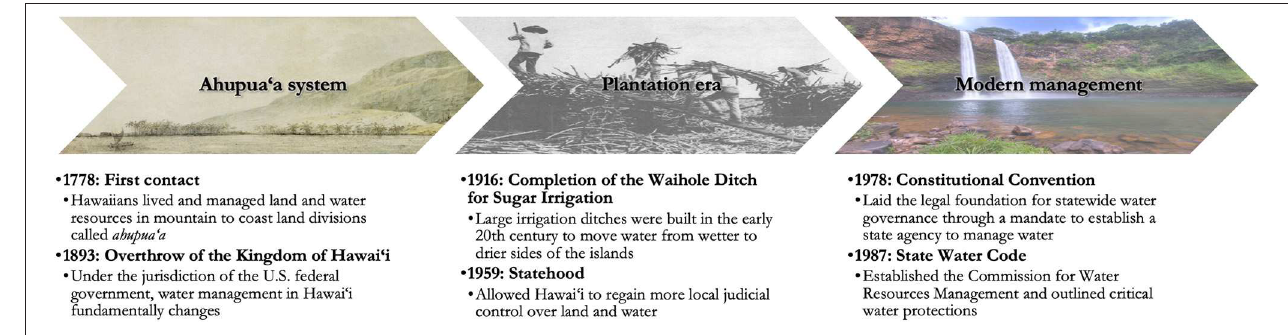
FIGURE 1 | History of water management in Hawai‘i in three major eras.